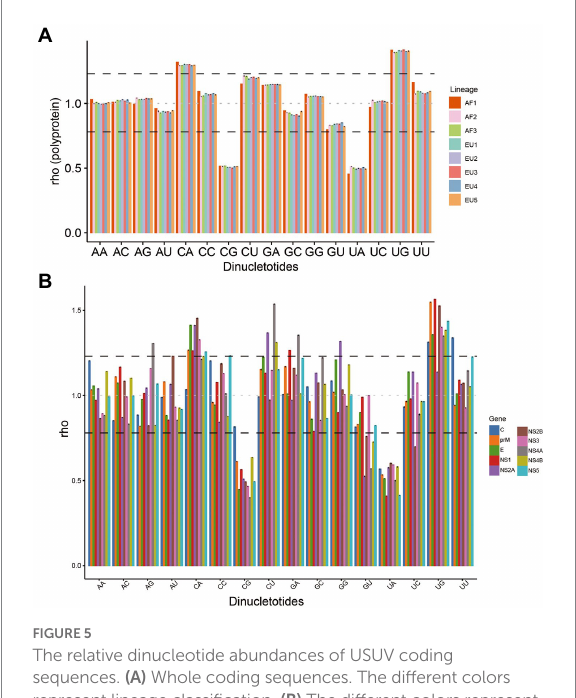
FIGURE 5 The relative dinucleotide abundances of USUV coding sequences. (A) Whole coding sequences. The different colors represent lineage classification. (B) The different colors represent different genes. The black dash lines indicate 1.23 and 0.78, respectively. The grey line indicates the expected frequency